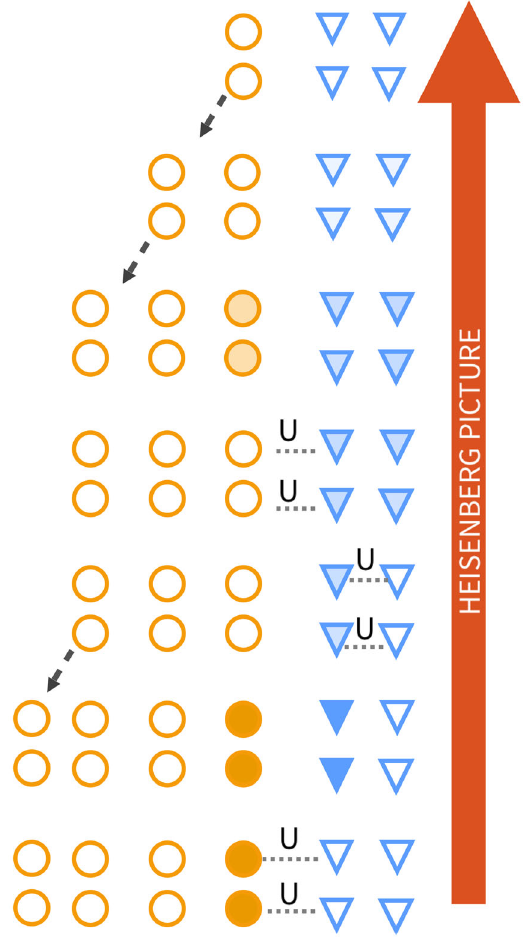
Fig. 2 Mixing and support growth in the Heisenberg picture. Evolution in the Heisenberg picture of an observable initially supported on the last two incoming qubits in the lower right corner ( fi lled orange corner) at the fourth time step. The U indicates that we apply a unitary between the involved qubits and the dashed arrows indicate that old qubits are shifted to the left. Note that we suppressed the unitaries that do not contribute to the expectation value. The distance of the observables to the identity is indicated by how fi lled the element, i.e., empty shapes indicate that the observable is proportional to the identity on that system. Note that as in the Heisenberg picture we discard qubits, this causes the observables to mix. Moreover, we see that after two iterations the observables are essentially proportional to the identity and it suf fi ces to implement that part of the circuit to estimate